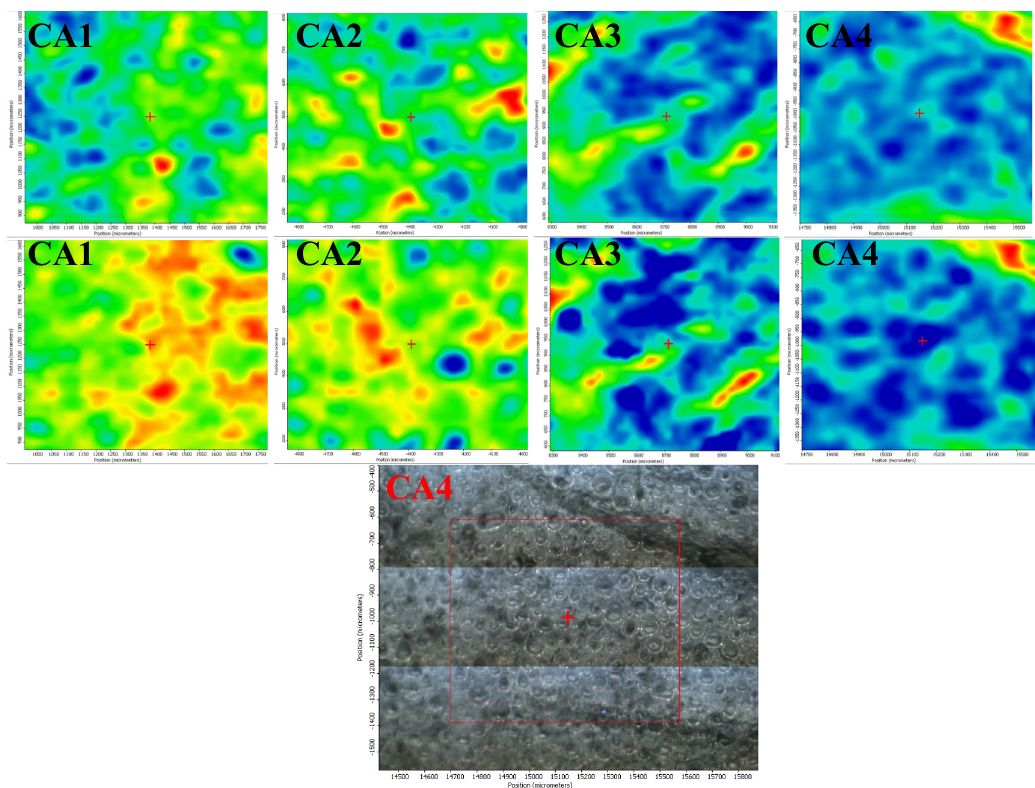
Figure 2. The FTIR maps for CA1–CA4 films at wavenumbers 3500 cm − 1 ( top row ) and 1740 cm − 1 ( intermediate row ); the last row represents the FTIR video image highlighting the morphology of the sample CA4 ( in fact, all these membranes have the same aspect ).